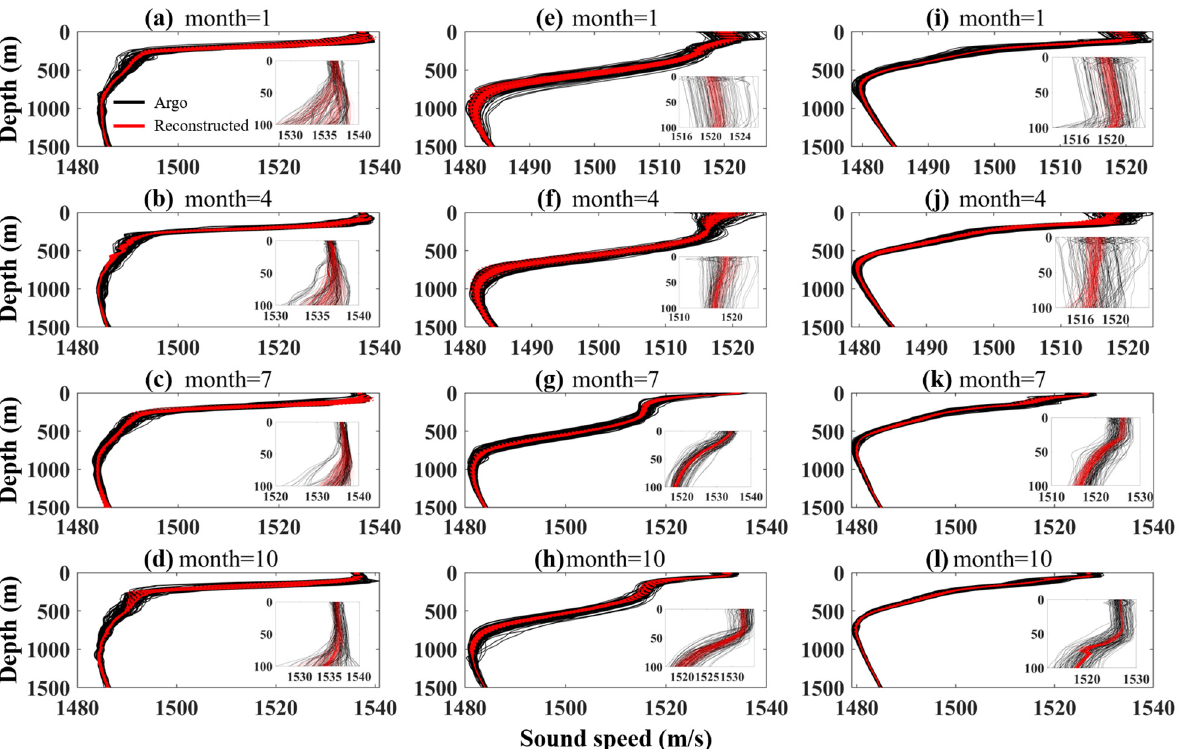
Figure 4. The SSPs in January, April, July, and October in Areas A ( a – d ), B ( e – h ), and C ( i – l ), with the black line and red line representing the Argo SSPs and reconstructed SSPs, respectively. The insets show the SSPs in the depth ranging from 0 m to 100 m.